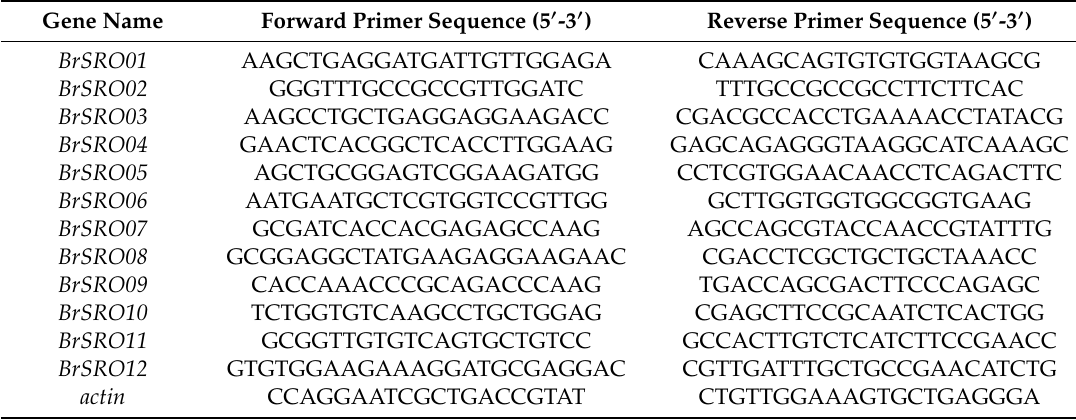
Table 3. The sequences of primers used for